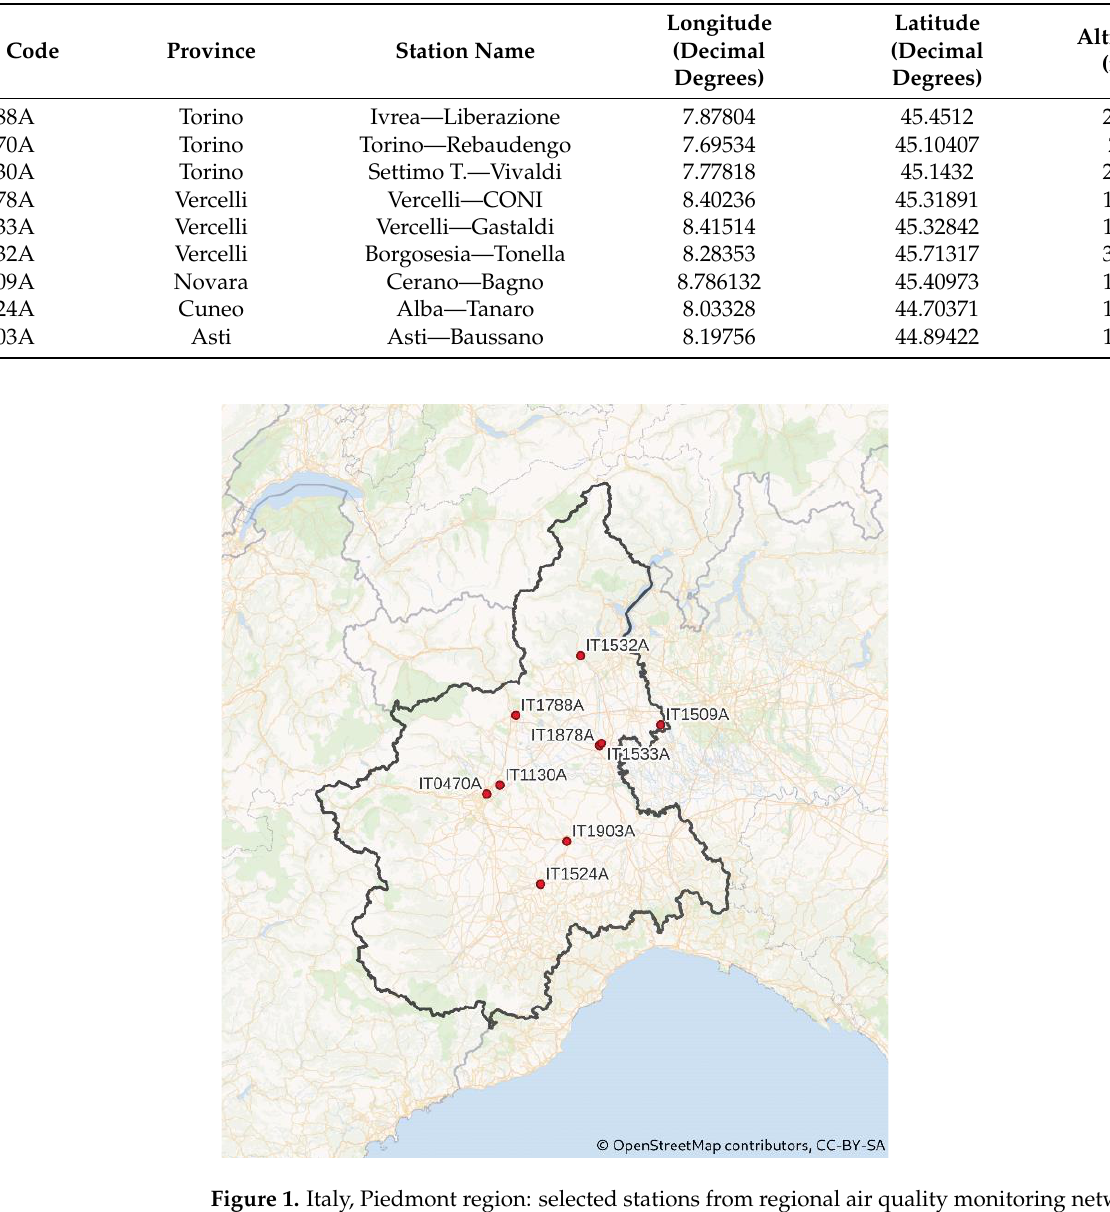
Table 1. Piedmont air quality monitoring stations information.